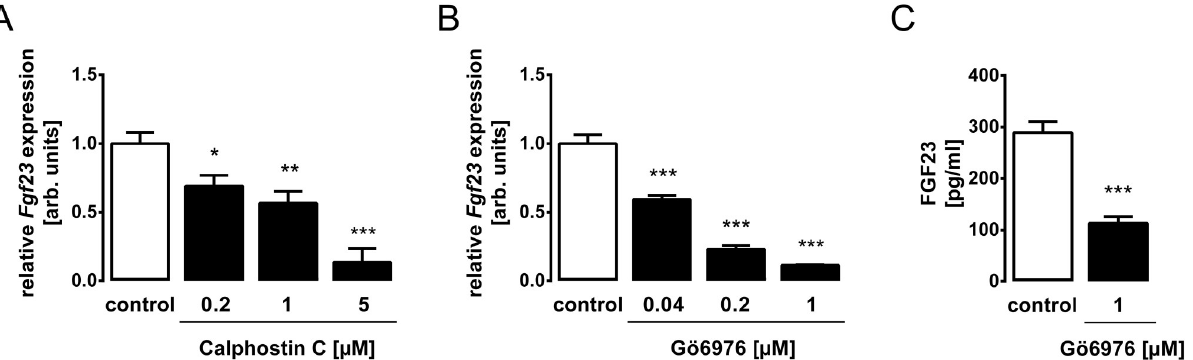
Fig 3. PKC inhibitors Calphostin C and Go¨6976 decrease FGF23 expression levels in UMR106 osteoblast cells. UMR106 cells were treated without and with PKC inhibitors Calphostin C ( A ) or Go¨6976 ( B, C ) at the indicated concentrations. Arithmetic means ± SEM (n = 6) of the relative Fgf23 mRNA abundance in UMR106 cells ( A, B ). Gene expression was normalized to Tbp as housekeeping gene. Arithmetic means ± SEM (n = 6) of FGF23 protein concentration in the cell culture supernatant ( C ). � p < 0.05, �� p < 0.01, and ��� p < 0.001 indicate significant difference. arb., arbitrary.